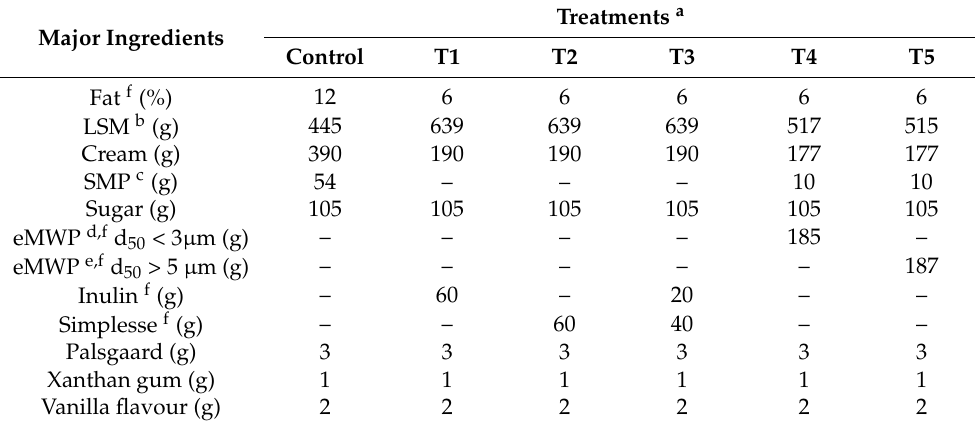
Table 1. Formulation of all treatments with and without microparticulated whey proteins.